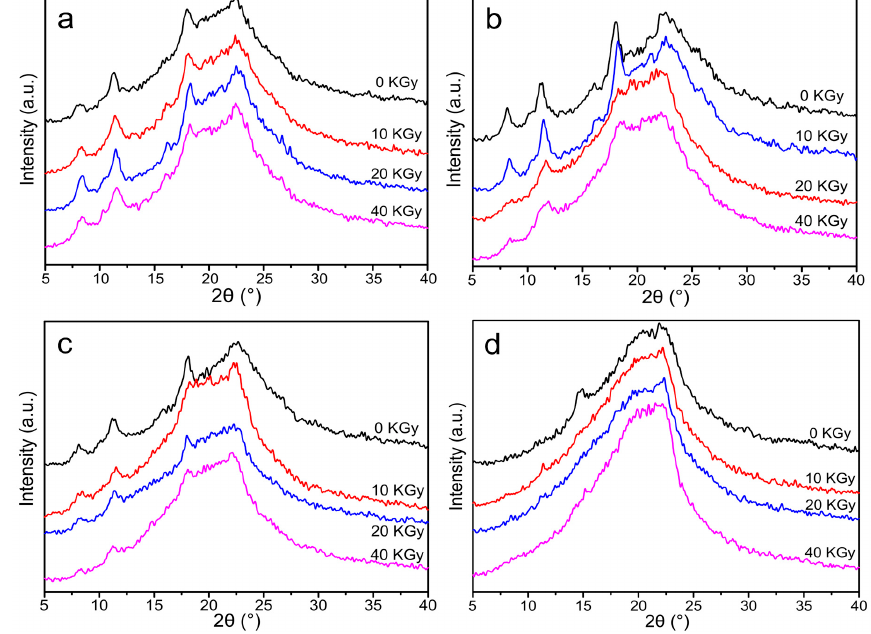
Figure 4. X-ray diffraction (XRD) patterns of CS/GO composite films with different content of GO: ( a ) 0 wt %; ( b ) 1 wt %; ( c ) 3 wt %; ( d ) 5 wt % under the various irradiation doses.